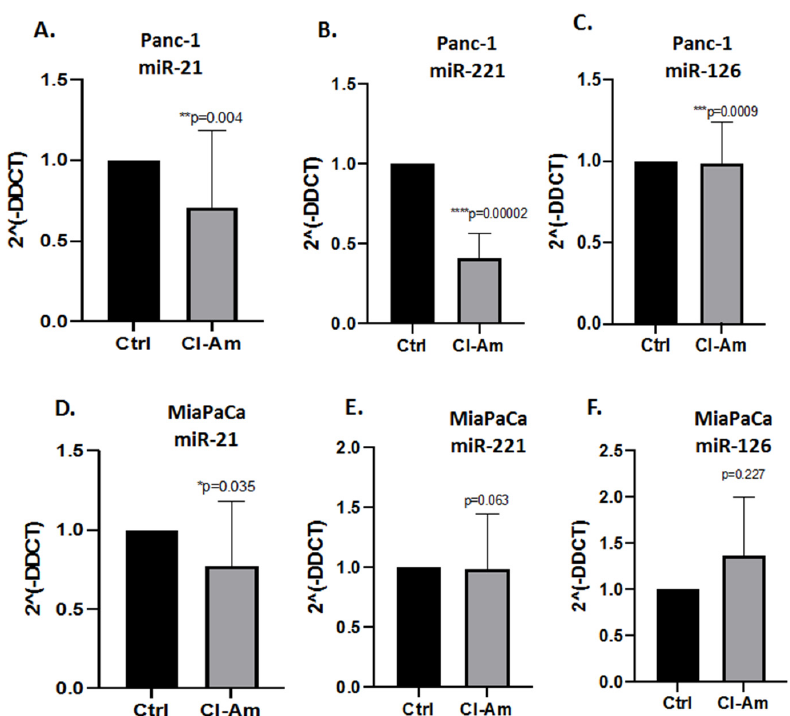
Figure 6. PAD inhibitor (Cl-amidine and isozyme-specific) mediated effects on EV microRNA cargo in PDAC cells. ( A – C) : Effects of Cl-amidine (1 h treatment at 100 μ m) in Panc-1 cell-derived EVs on: ( A ) miR-21; ( B ) miR-221; ( C ) miR-126. ( E – F ): Effects of Cl-amidine on MiaPaCa-2 cell-derived EVs (1 h treatment at 100 µ m) for: ( D ) miR-21; ( E ) miR-221; ( F ) miR-126. Exact p -values are indicated ( * p ≤ 0.05; ** p ≤ 0.01; *** p ≤ 0.001; **** p ≤ 0.0001); error bars indicate SD.